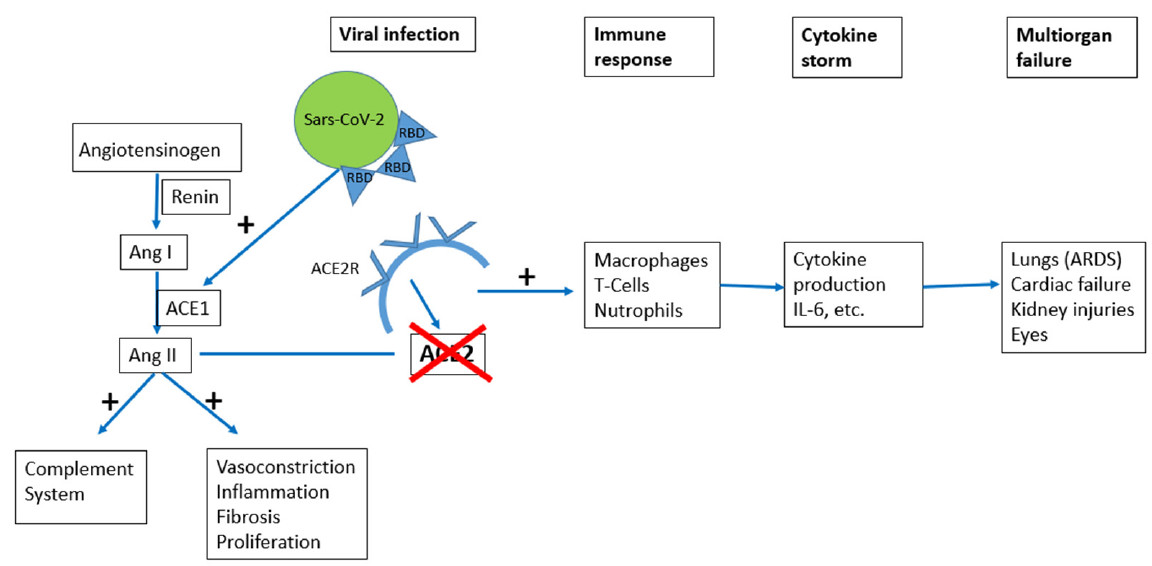
Figure 2. SARS-CoV-2 access and subsequent immune response. Ang I: angiotensin I; Ang II: angi- otensin II; ACE1: angiotensin converting enzyme 1; ACE2: angiotensin converting enzyme 2; ACER2: angiotensin converting enzyme receptor 2; RBD: receptor-binding domain.